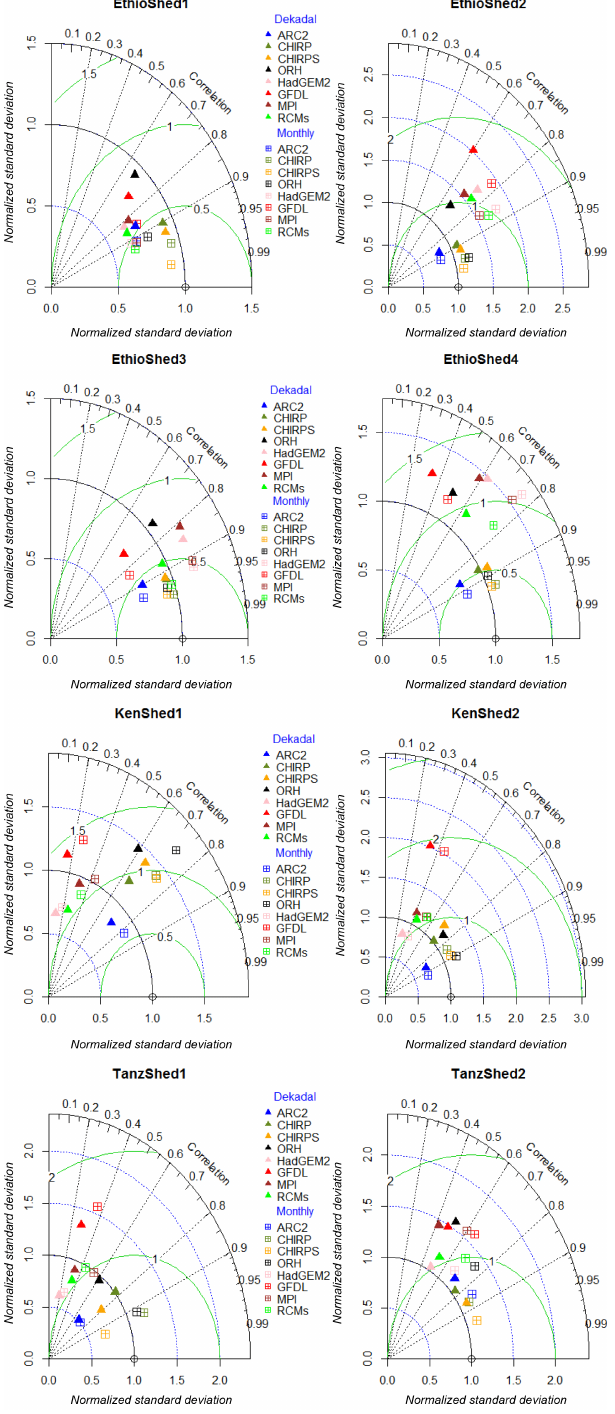
Figure 9. Taylor diagram displaying the agreement between ground observations and synthesized dekadal and monthly T max over eight validation areas of Ethiopia, Kenya, and Tanzania covering the pe- riod of